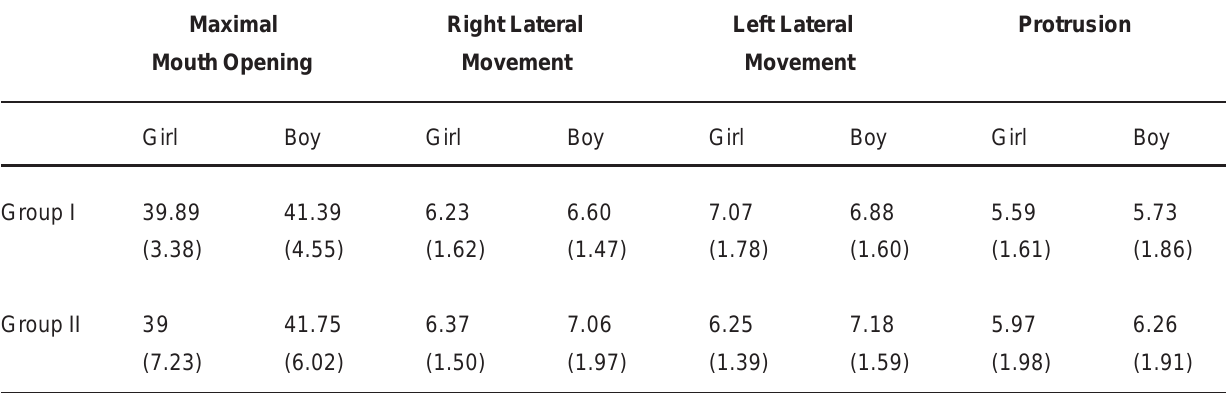
TABLE 2 - Mean values (standard deviations) of mandibular movements (mm) in relation to